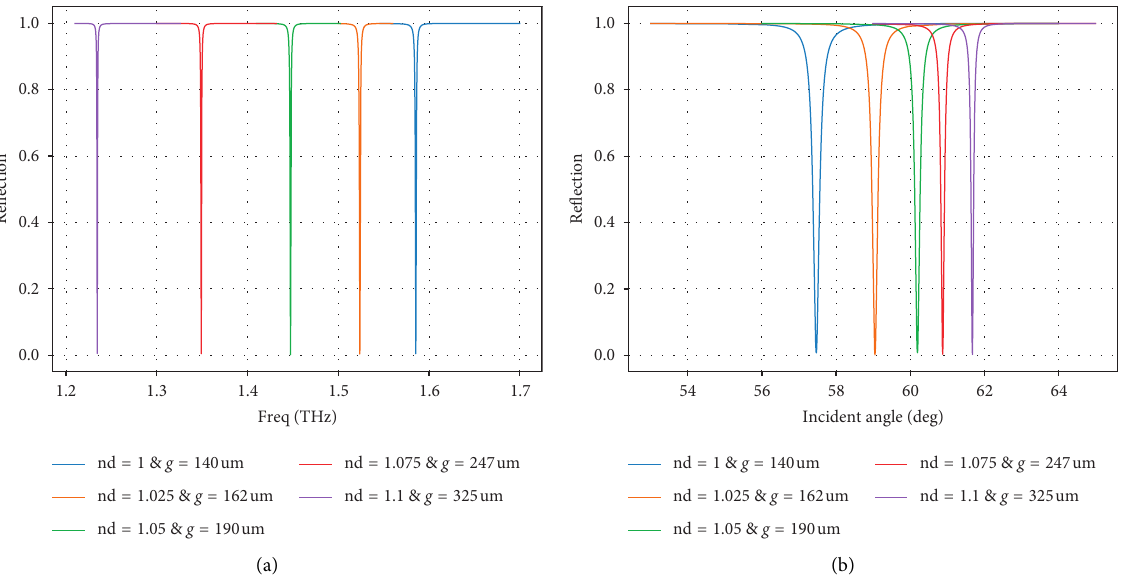
Figure 6: The reflectivity spectrum as a function of resonance frequency (a) and resonance angle (b) for the fluids filled with different refractive indexes under the optimal gaps.